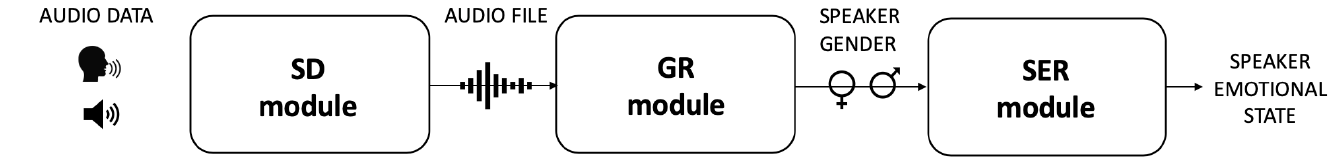
Figure 2. GESPER Architecture. Input audio data is sequentially processed by Speech Detector (SD), Gender Recognition (GR) and Speech Emotion Recognition (SER) modules for the final emotion